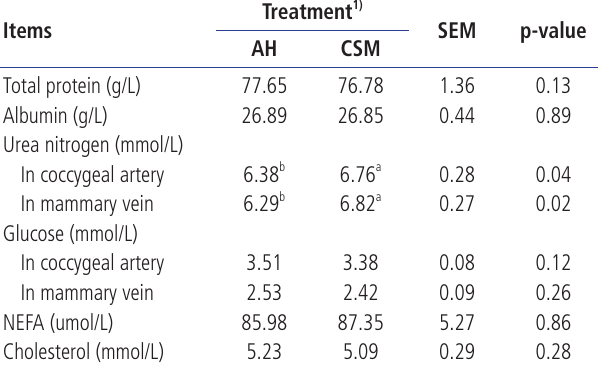
Table 4. Plasma metabolites of dairy cows fed experimental diets